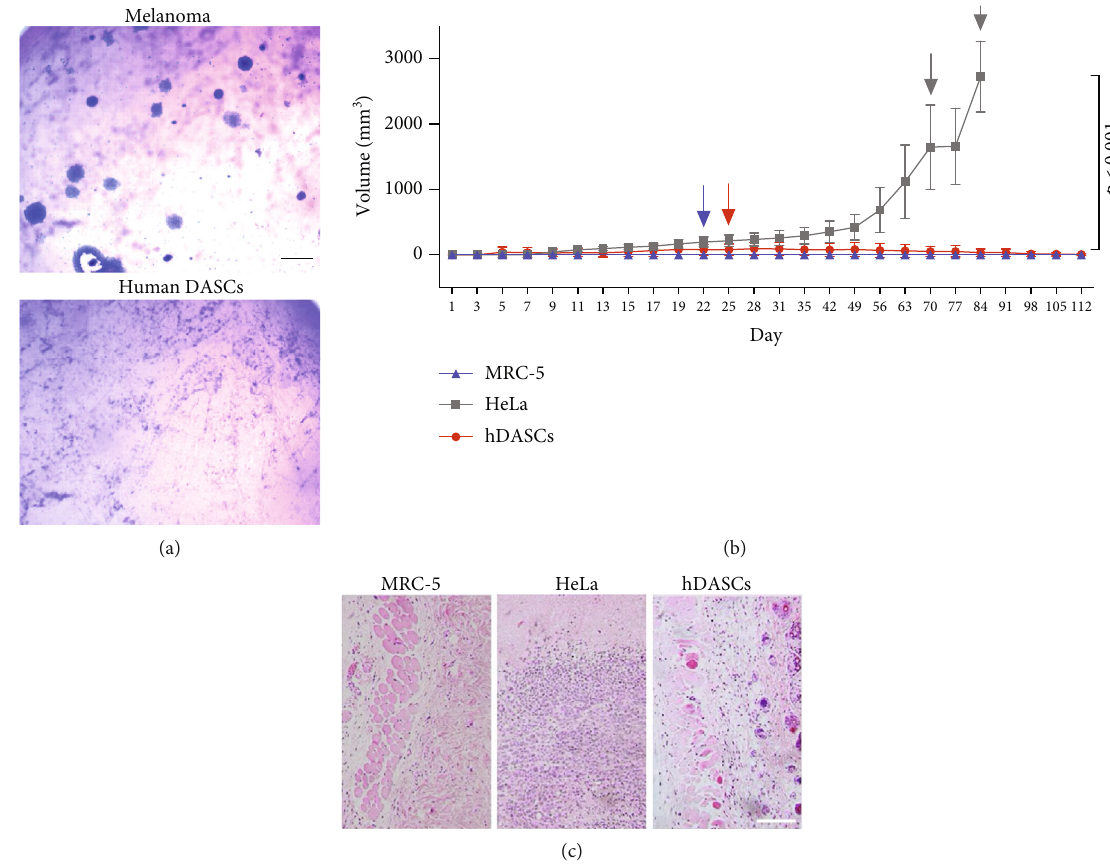
Figure 4: Evaluation of the tumorigenic potential of hDASCs. (a) Soft agar assay of melanoma and hDASCs. Scale bar, 200 μ m. (b) Growth curves of subcutaneous tumors in NOD-SCID mice formed by inoculation with either 10 7 human embryonic lung fi broblast cell MRC-5, 10 6 HeLa cells, or 10 7 hDASCs. The blue arrow indicates that 2 mice of the MRC-5 group were euthanized for gross observation and histopathological examination. The red arrow indicates that 2 mice of the hDASC group were euthanized for gross observation and histopathological examination. Grey arrows indicate that 4 mice and 6 mice of the Hela group were euthanized on day 70 and day 84, respectively, because the longest tumor diameter exceeded 20 mm. n = 5 in each group. (c) Representative H&E staining of di ff erent subcutaneous grafts. Scale bar, 100 μ